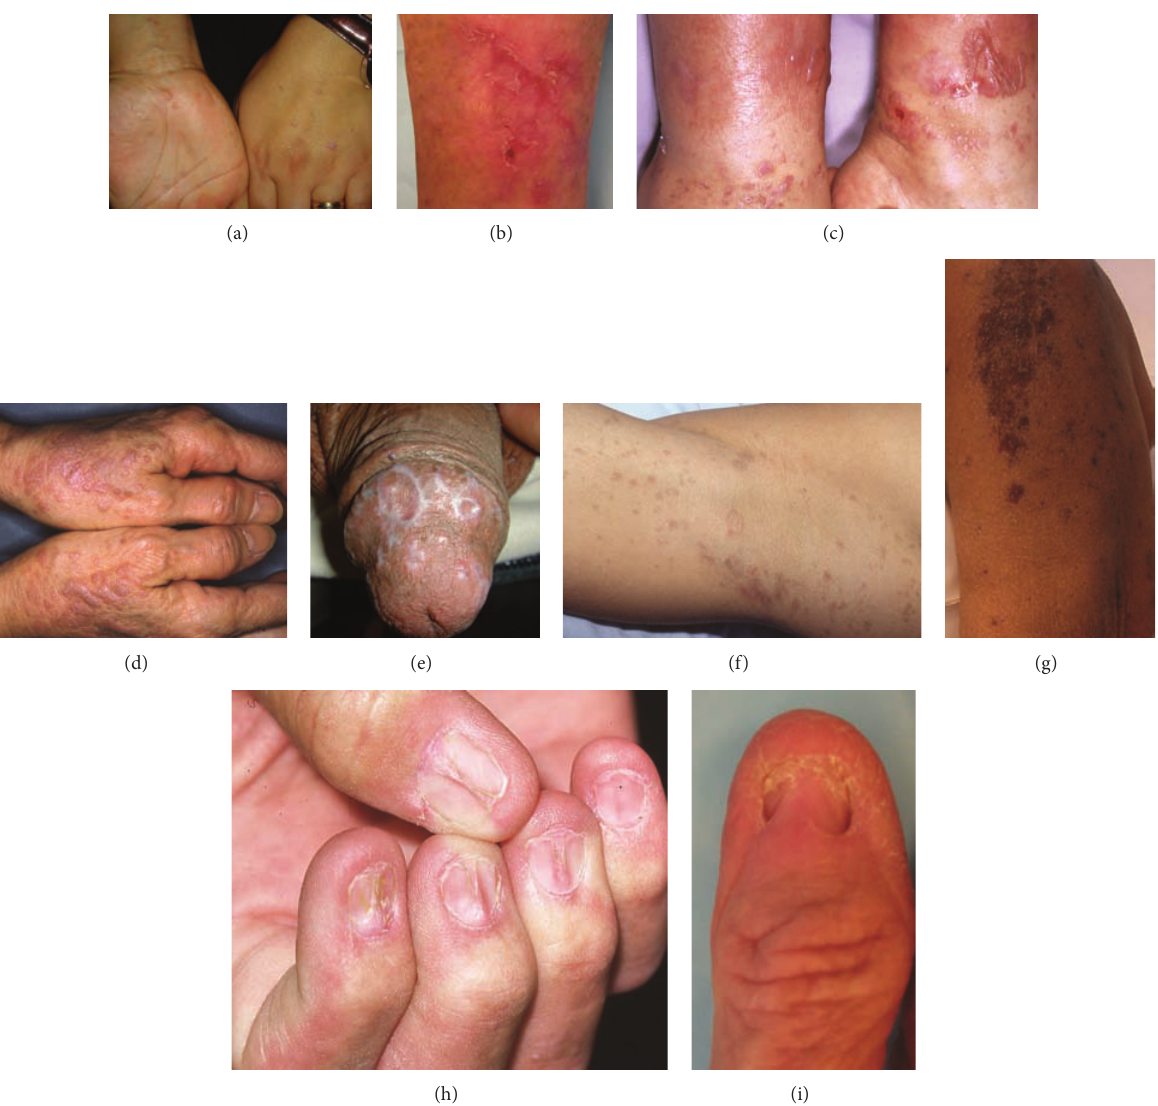
Figure 1: (a) Classic CLP: violaceous Papules on the dorsal hand and volar wrist (courtesy of Dr. Omid Zargari); (b) hypertrophic CLP: centrally eroded hyperkeratotic plaques involving the lower leg; (c) vesiculobullous CLP: vesicles and bullae on right and left ankles and lower legs (courtesy of Dr. Peter Lynch); (d) actinic CLP: hyperpigmented Papules and plaques on the dorsal hands (courtesy of Dr. Peter Lynch); (e) annular CLP: reticulated white striae involving the glans penis (courtesy of Dr. Omid Zargari); (f) atrophic CLP: hyperpigmented macules and patches on the arm (courtesy of Dr. Peter Lynch); (g) zosteriform CLP: linearly oriented confluent violaceous Papules on the arm; (h) nail CLP: longitudinal ridging of the fingernails (courtesy of Dr. Peter Lynch); (i) nail CLP: dorsal pterygium of the thumbnail; (a), (b), (e), (g), and (i) are reprinted with permission from [50]. CLP, cutaneous lichen planus.